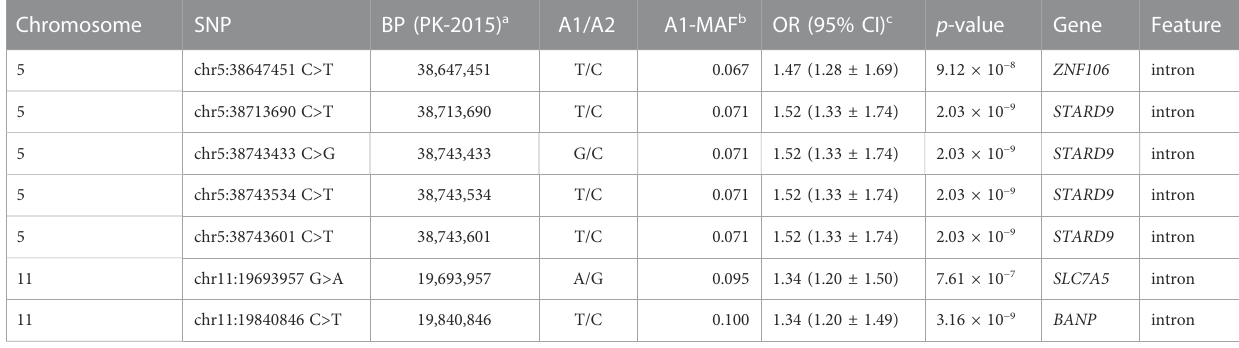
TABLE 1 SNPs with genome-wide signi fi cance associations for plumage color traits.